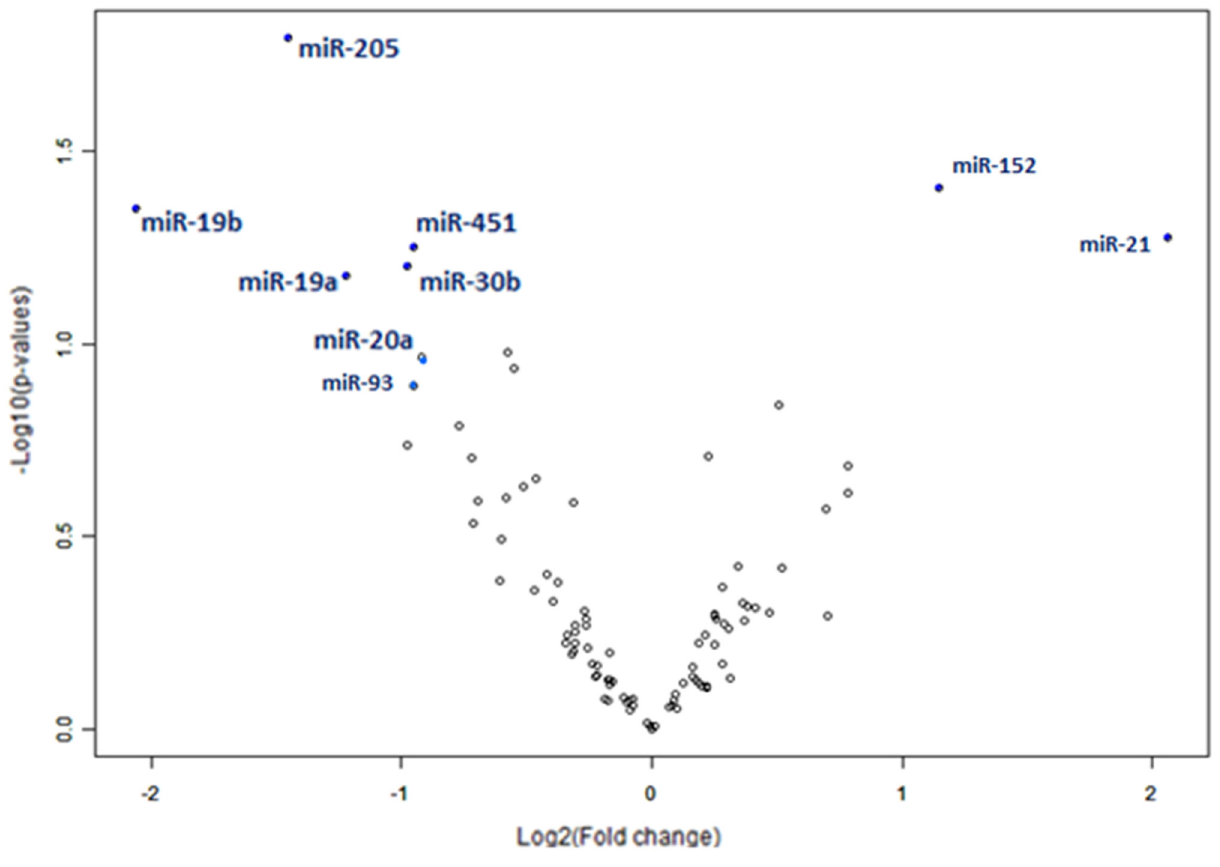
Scatter plot of pre-/post-surgery ratios for expression of the analyzed miRNAs in patients with lung SCC. Analysis was performed with BRB-ArrayTools software. A group of miRNAs on the left side of the plot (miR-205, -19a, -19b, -451, -30b, -20a, and -93) are the most abundant in the plasma of lung SCC patients and are reduced in the plasma after tumor